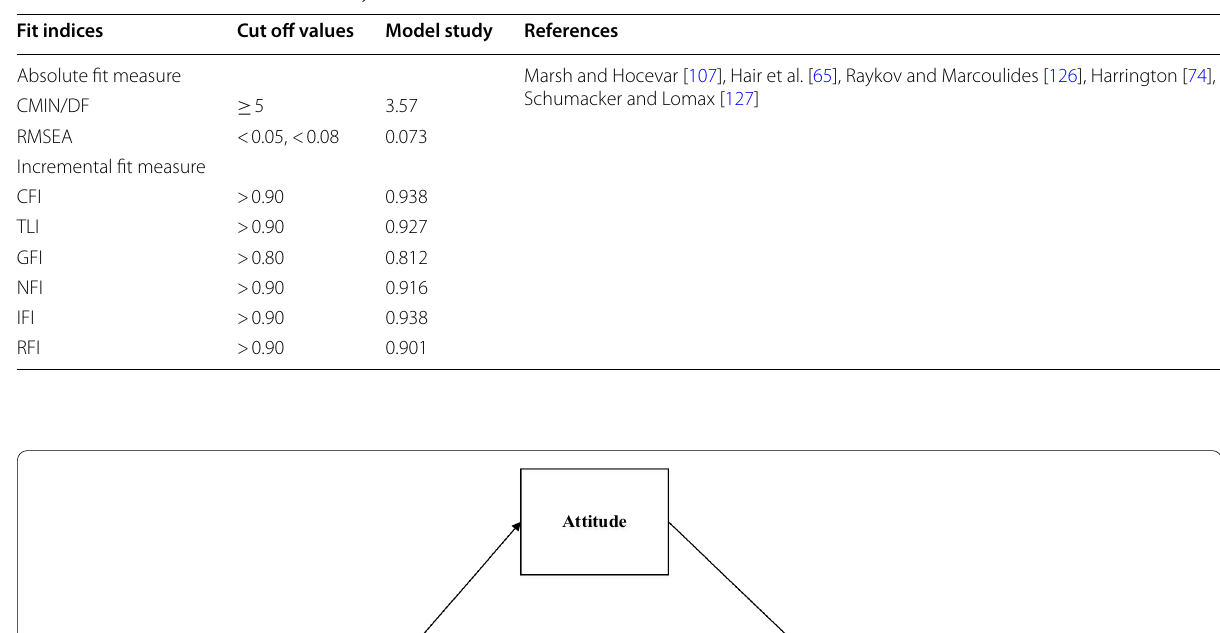
Table 6 SEM fit indices. Source : Primary data